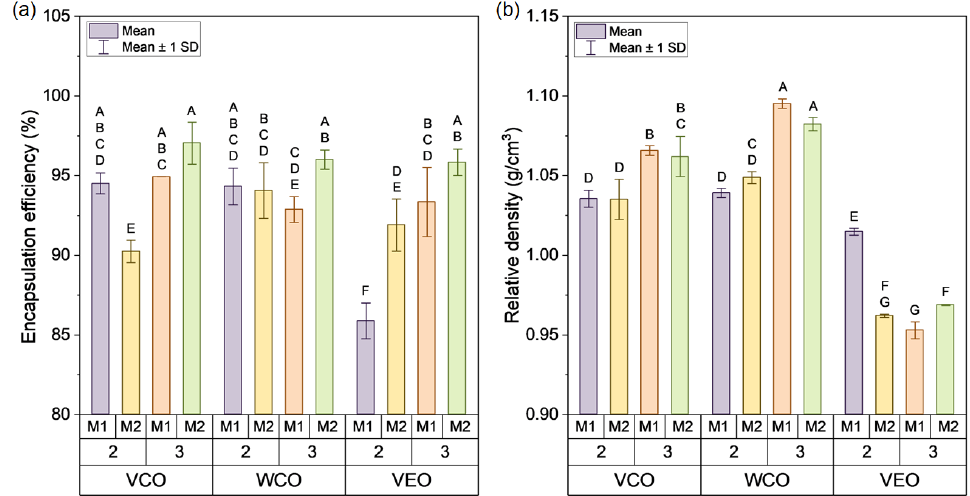
Figure 5. Average results of ( a ) encapsulation efficiency and ( b ) relative density of each capsule. To evaluate if the differences evidenced in the morphological (size, sphericity) and